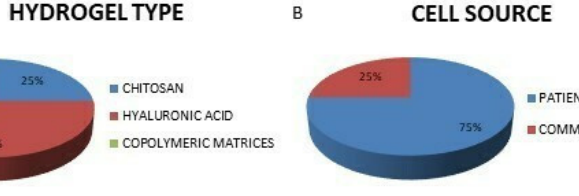
Figure 2. Diagrams with relative percentages of ( A ) type of hydrogel used; ( B ) sources of the cells; and ( C ) cell phenotype.